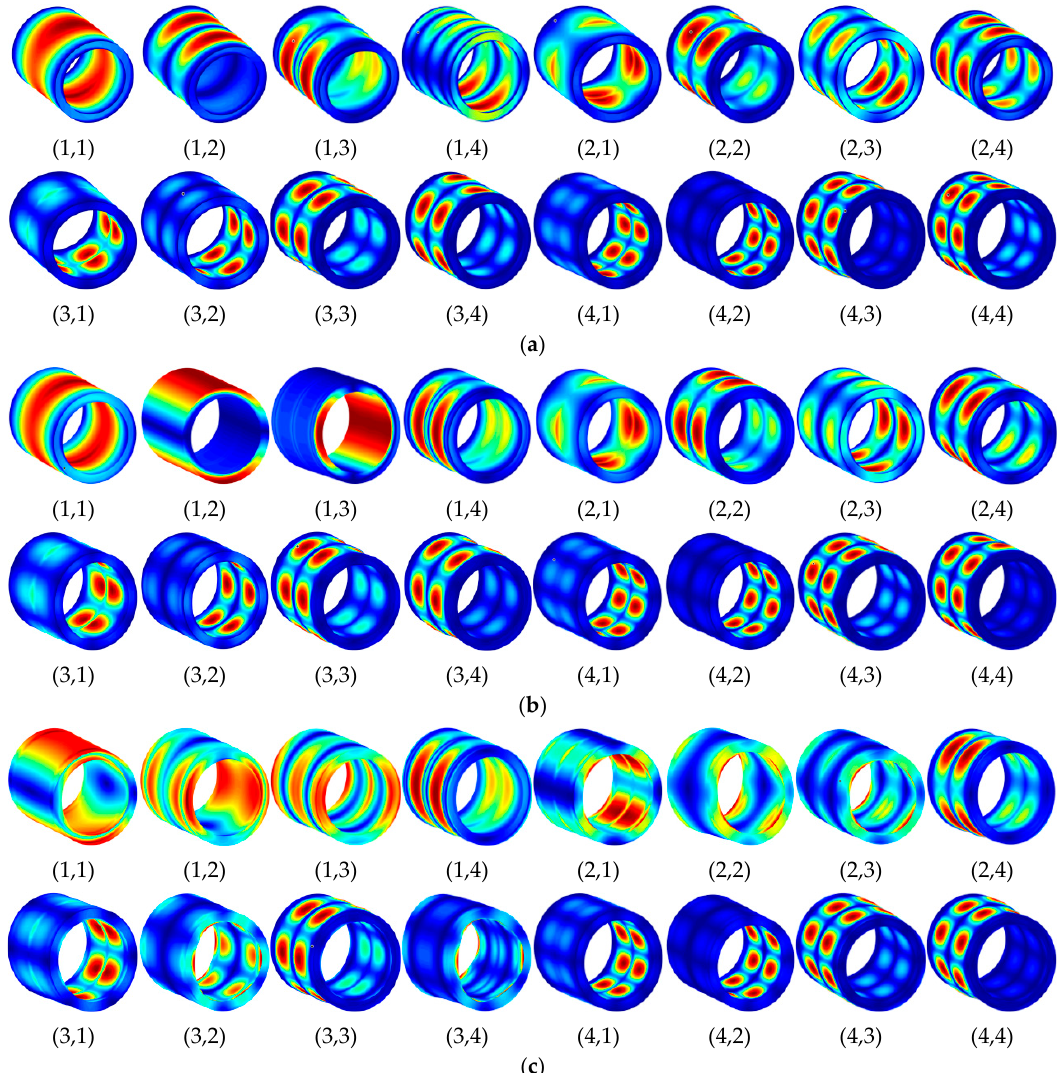
Figure 2. Mode shapes of DCSS with different boundary conditions. ( a ) CC-CC; ( b ) SS-SS; ( c ) FF-FF.